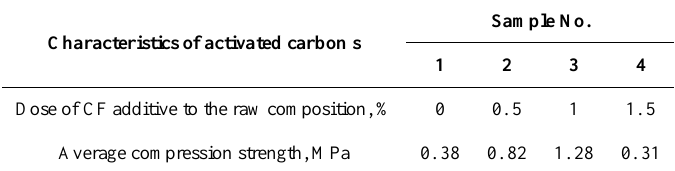
Table 5. Strength of organoplastic-based activated carbon pellets reinforced with obtained